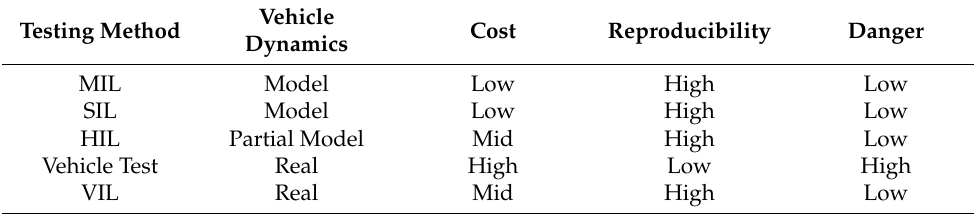
Table 1. Comparison of various testing methods for a